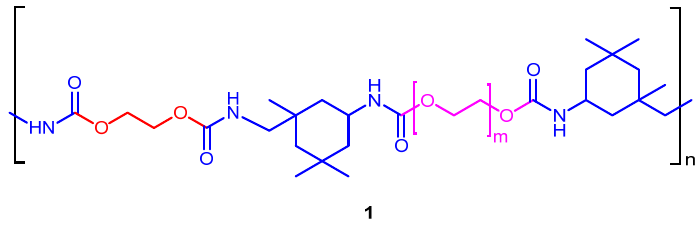
Figure 1. Structure of polyurethane 1.